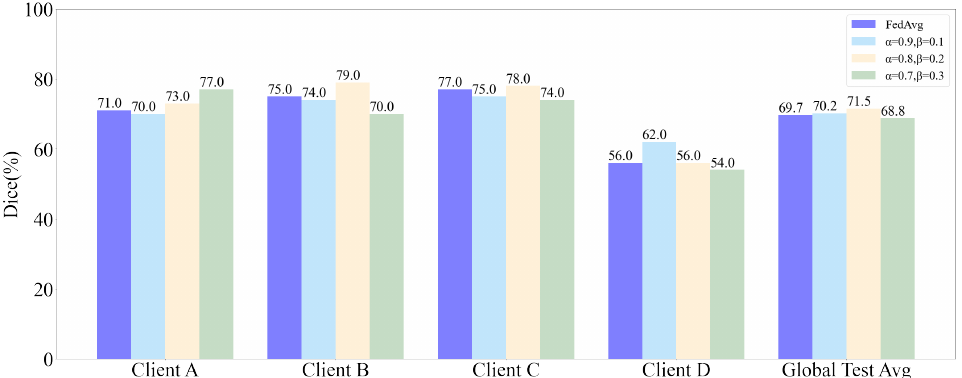
Figure 8. Visualizations of the effect of different α and β on the training